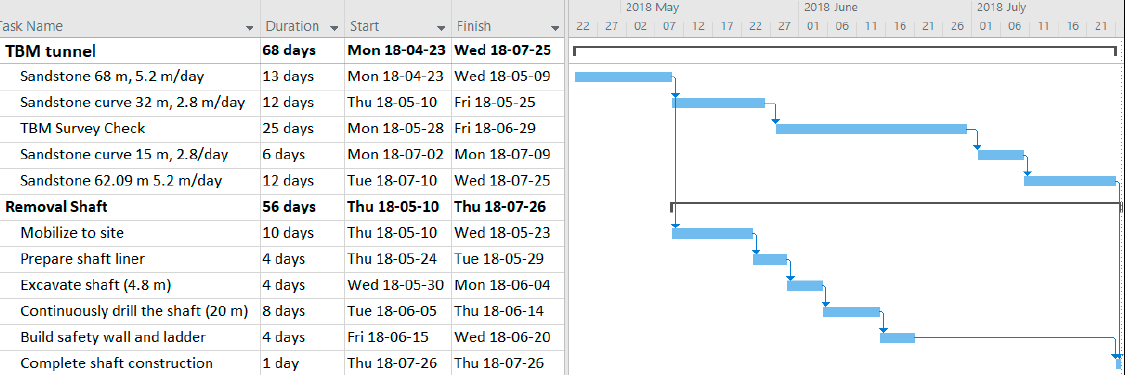
Figure 6. Updated schedule of the tunneling segment.